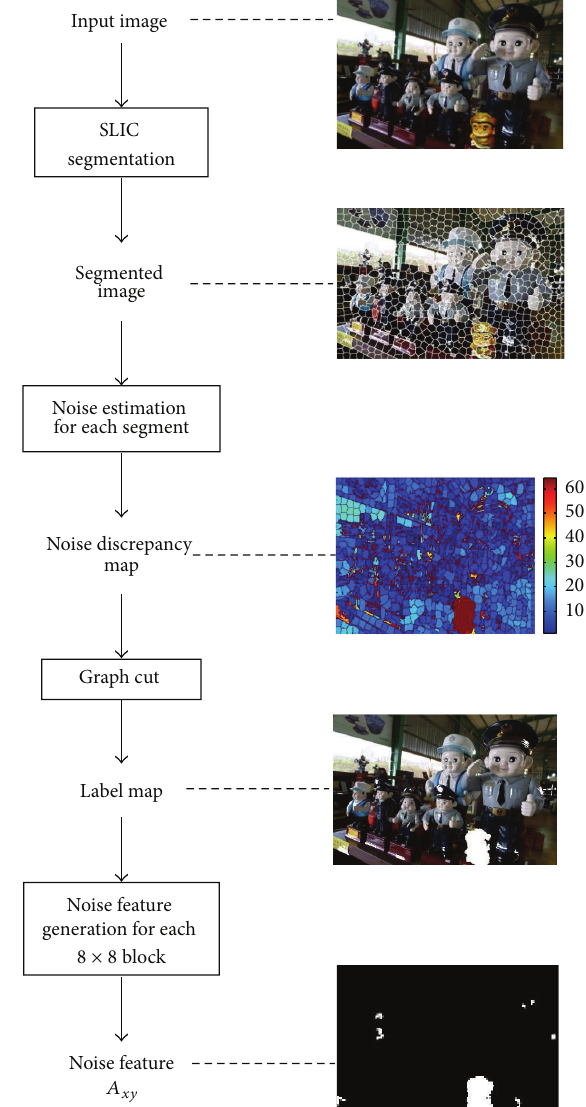
Figure 5: Flowchart of proposed method: noise feature